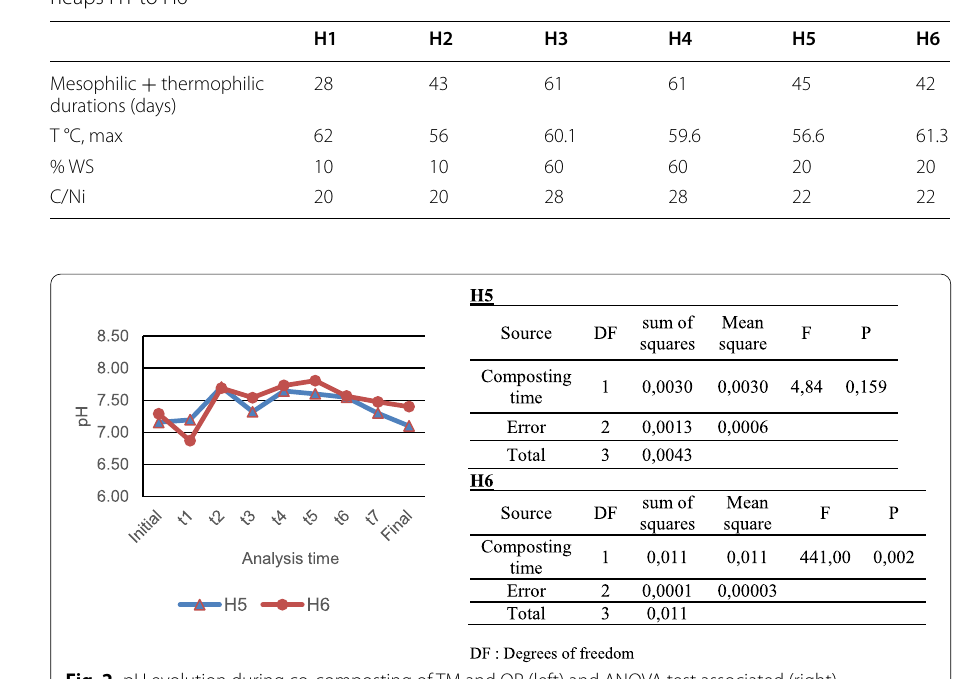
Table 4 Mesophilic and thermophilic durations, and maximum temperatures (T °C, max) in the heaps H1 to H6